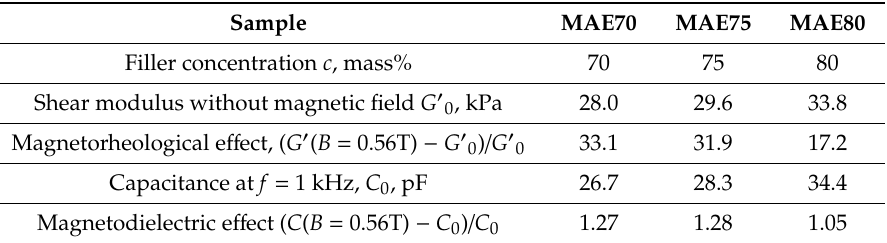
Table 1. Sample Table 1. Sample characteristics.